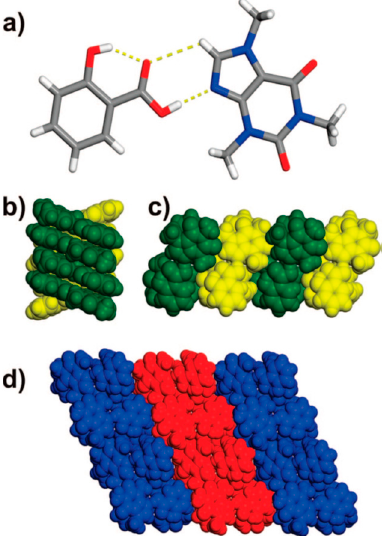
Figure 11. (a) Acid-imidazole synthons between 2HBA and caffeine, respectively. (b-d) Crystal packing of the resultant 1:1 cocrystal. Adapted with permission from Cryst. Growth Des., 2009, 9 (4), 1932–1943. Copyright 2009, American Chemical Society.